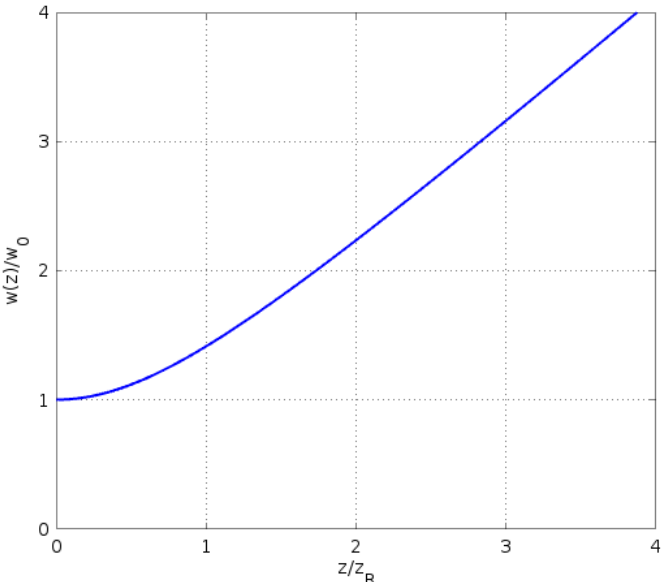
Figure 3. The beam radius of a Gaussian beam along the direction of